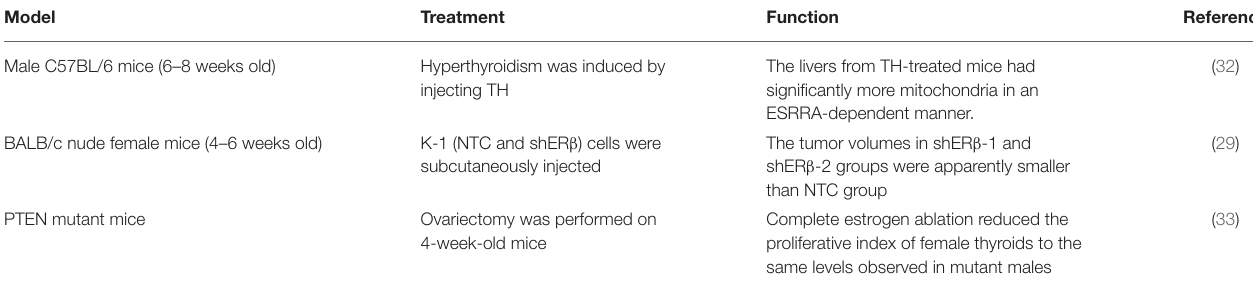
TABLE 2 | The effect of the signaling pathway of estrogen in vivo